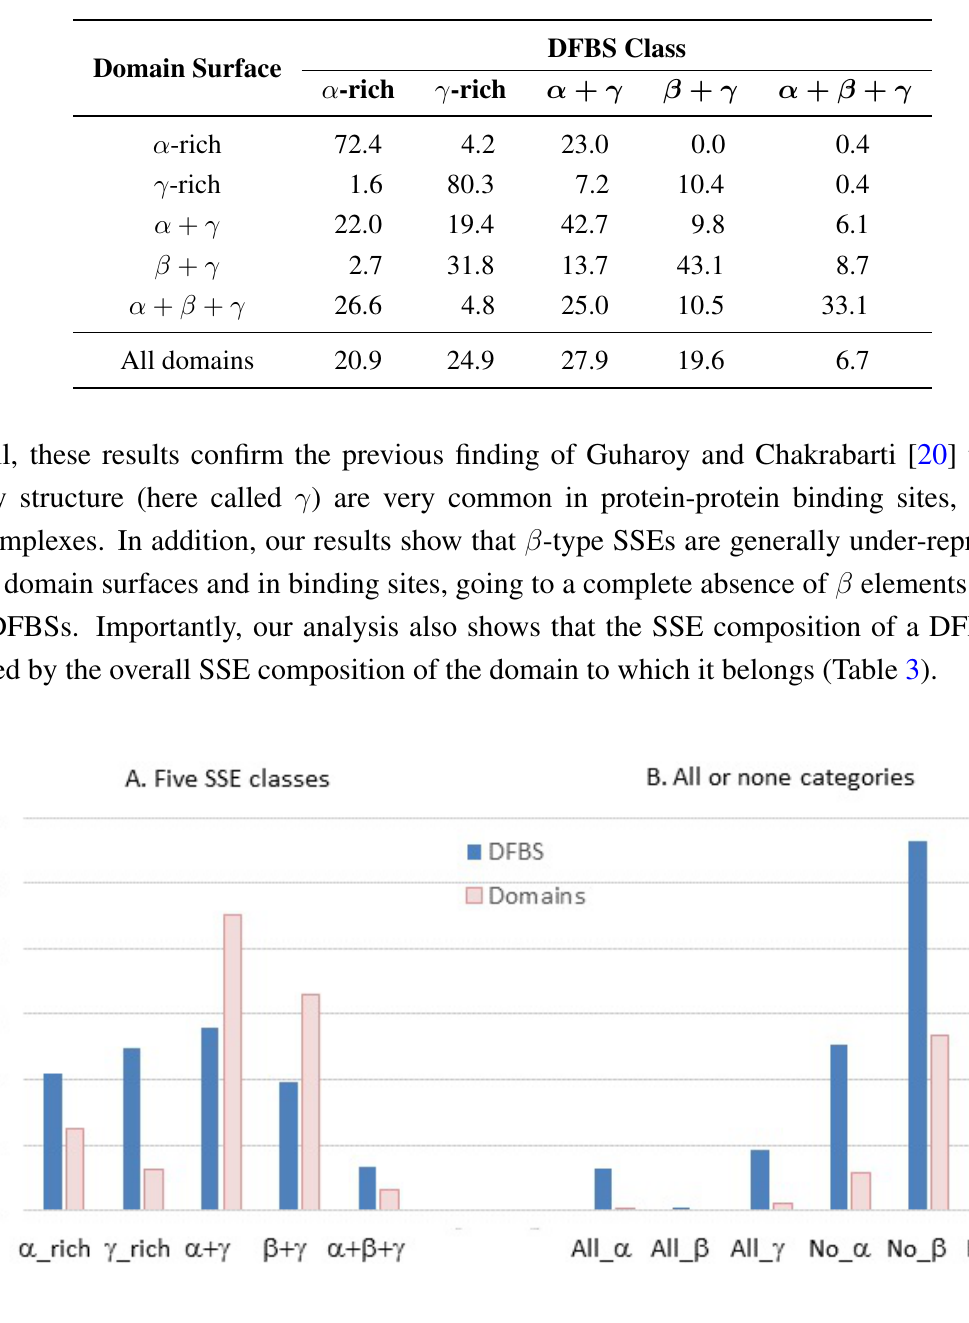
Figure 2. Histogram of the distribution of DFBSs and domain surfaces over the five SSE classes ( left ) and the “all” or “none” SSE categories ( right